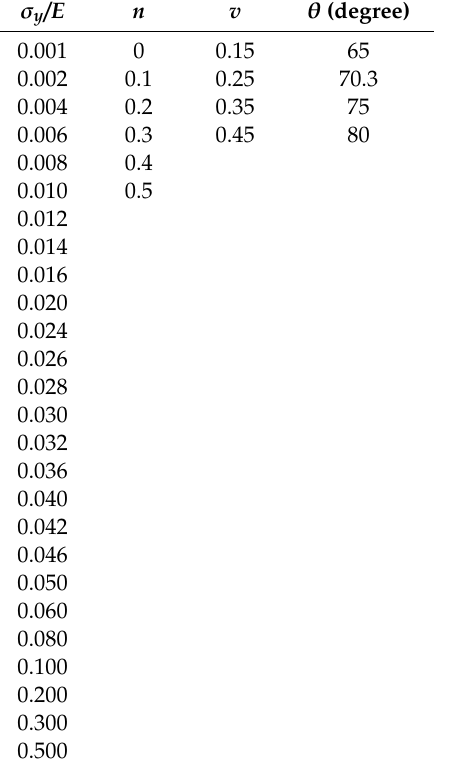
Table A1. Elasticity and plasticity